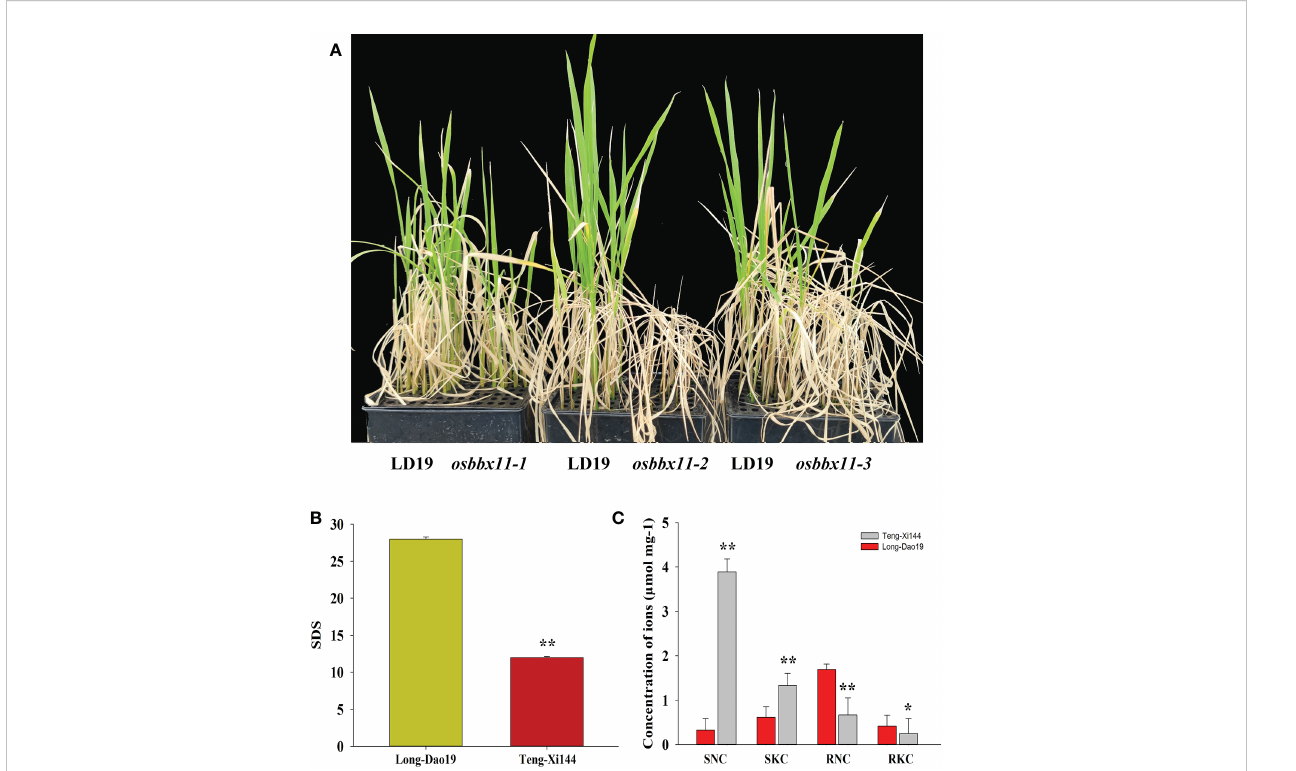
FIGURE 6 Functional analysis of rice ’ s B-box zinc fi nger family protein LOC_Os04g41560 ( OsBX11 ). (A) Salt tolerance phenotype of knockout plants after 10 days of salt stress and 12 days of resuming growth in a non-salt environment. (B) Comparison of seedling survival days after salt stress between knockout and wild-type plants. (C) Comparison of Na +1 and K +1 concentrations in roots and shoots of knockout and wild-type plants after salt stress. **P < 0.01; Student ’ s t-test *P < 0.05; Student ’ s